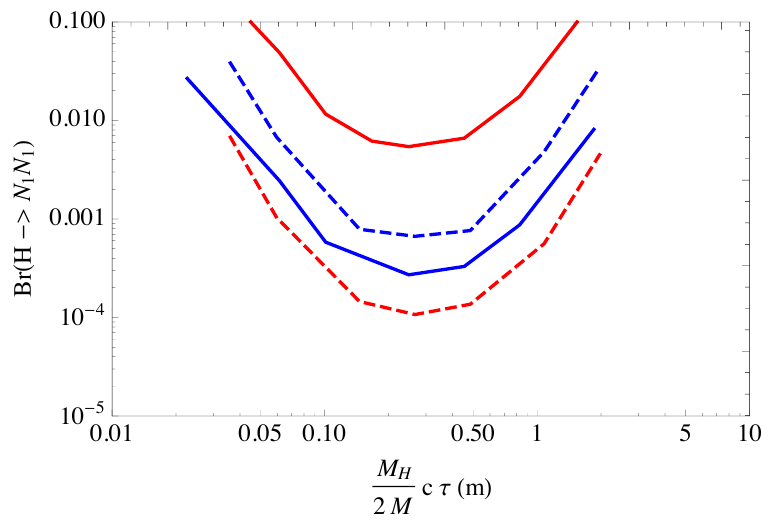
N 1 N 1 ) for scenario A as a ! (cid:25)= 2 (blue) or (cid:30) 1 = (cid:25)= 2 (cid:0)